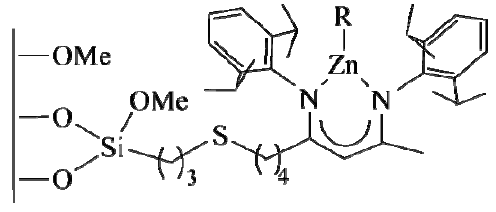
Figure 10. Zinc β -diiminate anchored onto mesoporous silica